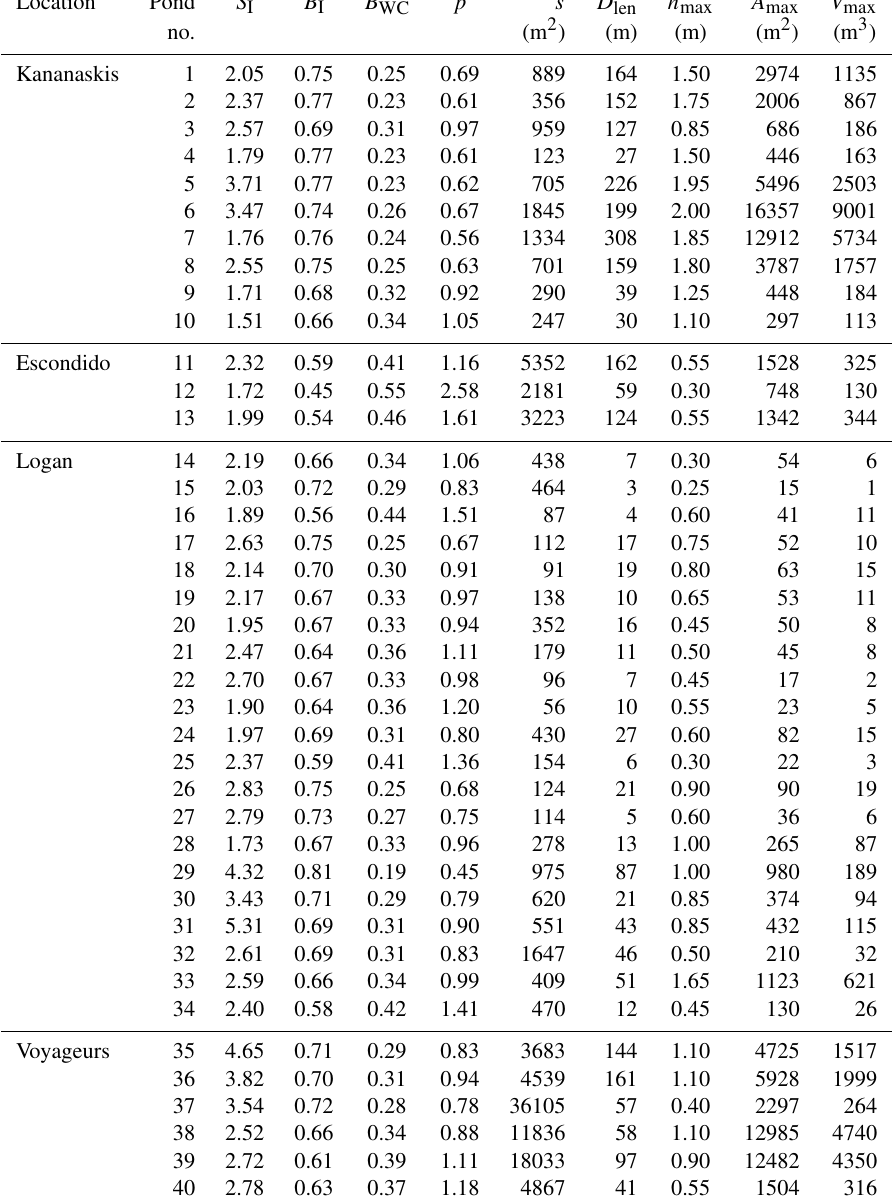
Table 2. Pond morphometric characteristics, including the full model morphometry ( p ) and scaling ( s ) coefficients, shape index ( S I ), bathy- metric integral ( B I ), bathymetric water capacity ( B WC ), length of the dam ( D len ), and maximum depth ( h max ), area ( A max ), and vol- ume ( V max ) of the